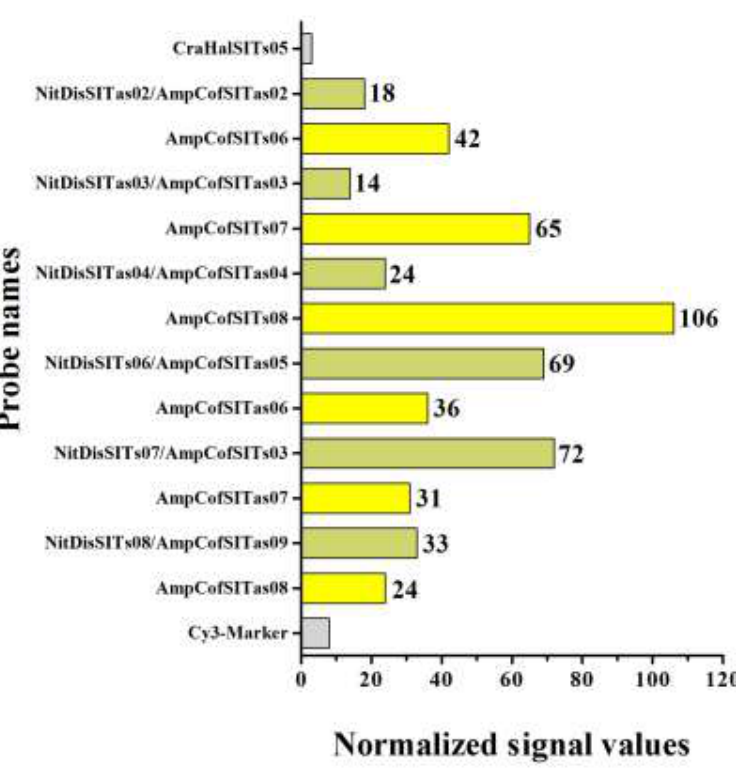
Figure 6. Quantification results of microarray hybridization experiments targeting SIT gene of Amphora coffeaeformis . On the Y-axis are reported the probes producing a fluorescent signal after hybridization: yellow bars correspond to probes displaying high specificity, green bars indicate probes with lower specificity, while gray bars correspond to probes producing false-positive signals. The fluorescence intensity signals are reported on the histogram